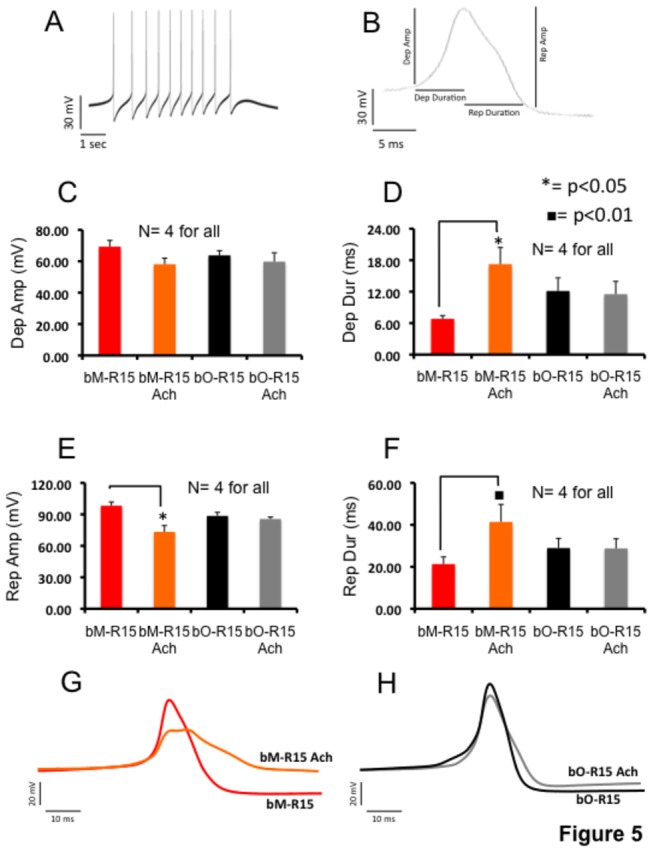
Analysis of action potential waveform in rhythmic bursting R15 from mature and old animals.A: action potentials in a single burst. B: measurements of waveform parameters (Depolarization amplitude, Depolarization Duration, Repolarization amplitude, Repolarization duration). Bar graphs showing the mean depolarization amplitude (C), the mean depolarization duration (D), repolarization amplitude (E), repolarization duration (F) of AP waveforms recorded in rhythmic R15 bursting neurons from old and mature animals, before and after 1 mM ACh application. Values are expressed as mean ± SEM. mV: milli volt; msec: milli seconds. An asterisk or a black-filled square indicates statistically significant differences. Differences were considered significant (n=4; One way ANOVA and Tukey’s HSD test) at the level of p <0.05 (asterisk) or p <0.01 (square). G & H: Representative action potentials waveforms of R15 bursting activity recorded in bM-R15 (G) and bO-R15 (H) neurons before and after 1 mM ACh application. bM-R15: rhythmic bursting R15 from mature animals; bO-R15: rhythmic bursting R15 from old animals, bM-R15 ACh and bO-R15 ACh are bM-R15 or bO-R15 neurons after ACh exposure.